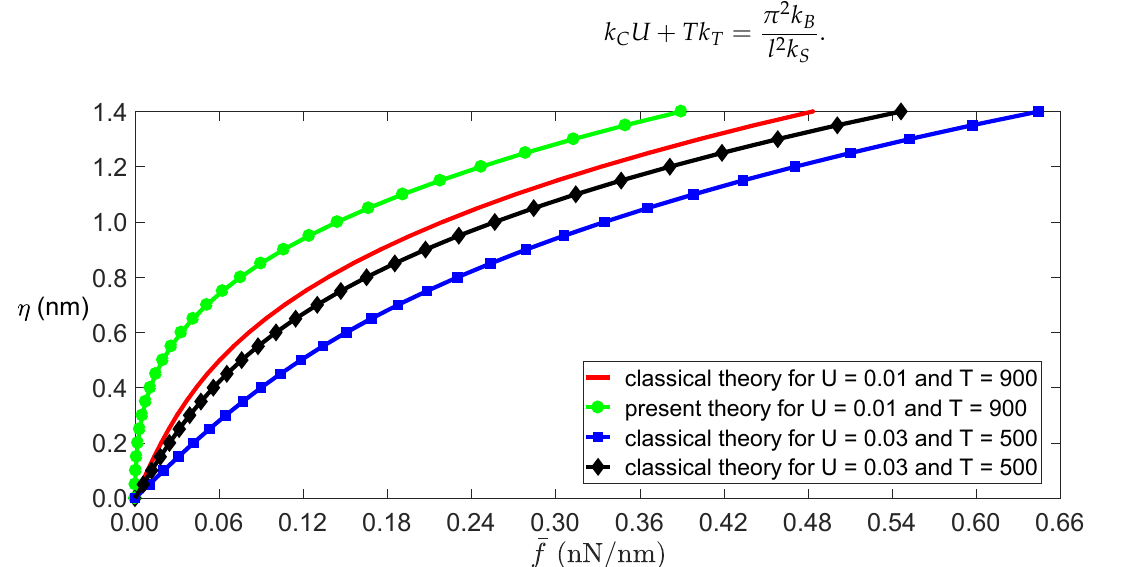
Figure 2. Amplitude of the deformation as a function of the load for the given temperatures and electric fields.